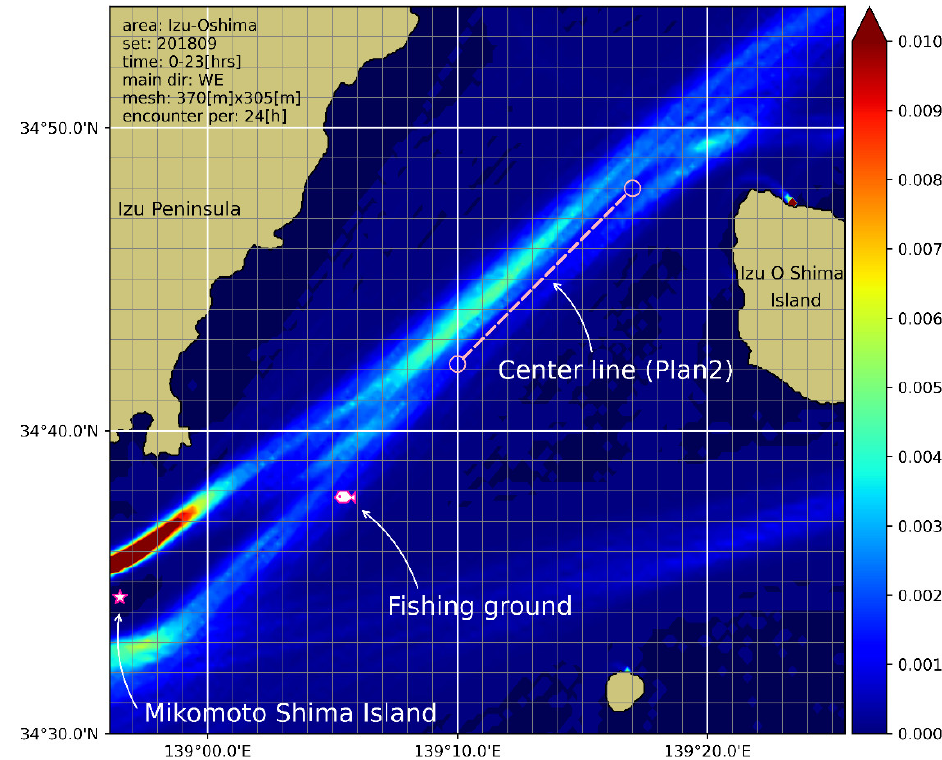
Figure 14. Distribution map of the encounter frequency of sailing ships with opposite directions (8 months after the implementation (September 2018)). (Sources: AIS data from 1 September to 30 September 2018, provided by TST [32]).